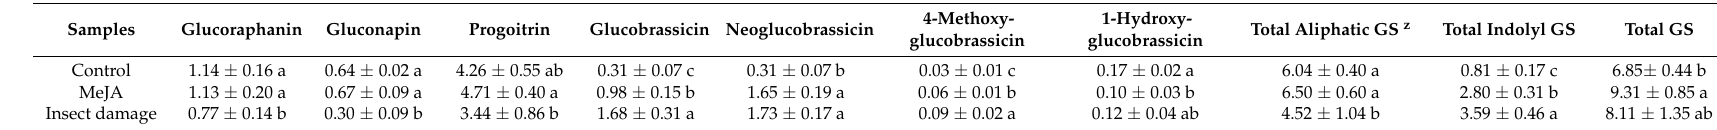
Table 1. Glucosinolate profiles ( µ mol · g -1 DW) of “Red Russian” controls and kale plants treated with 250 µ M methyl jasmonate (MeJA) or infested with cabbage looper for 4 days y .